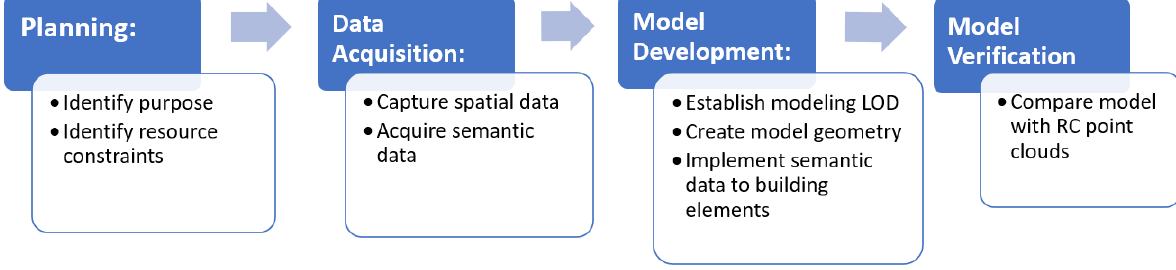
Figure 1. HBIM program